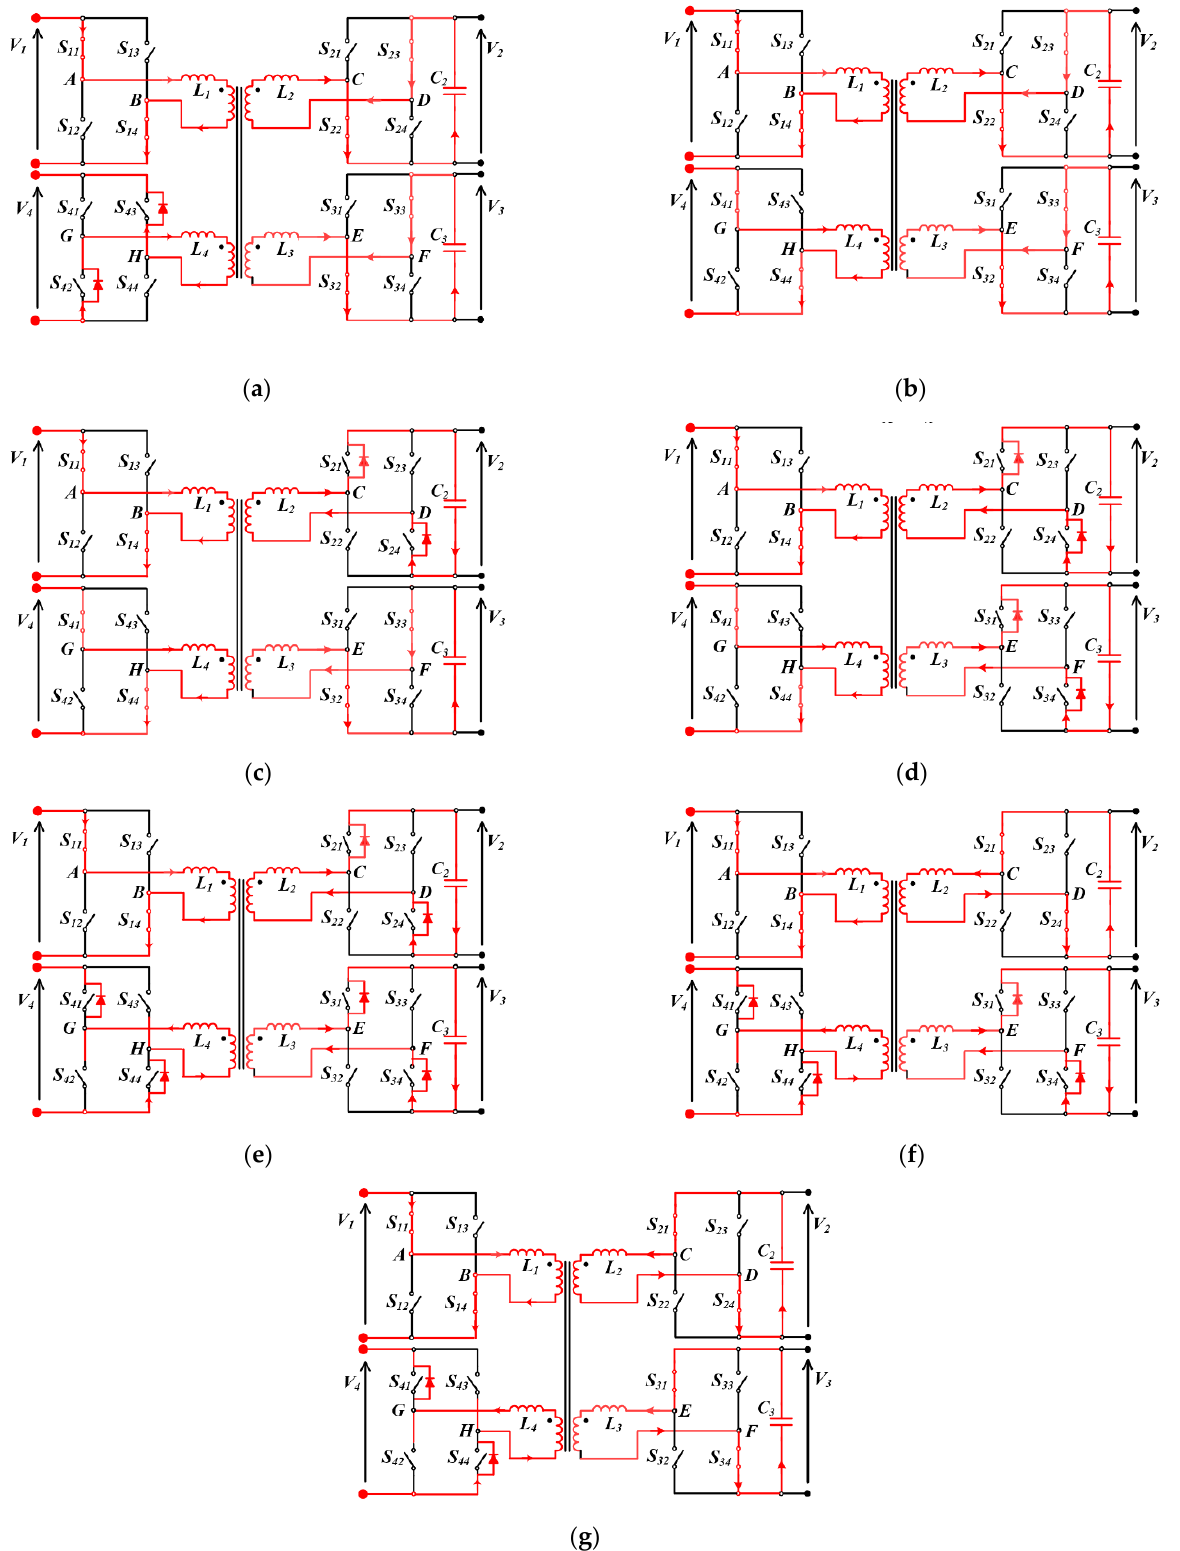
Figure 10. Equivalent circuit of the multi-port DAB converter: ( a ) time-interval 1 [0 < t < ϑ 14 ], ( b ) time-interval 2 [ ϑ 14 < t < ϑ 12 ], ( c ) time-interval 3 [ ϑ 12 < t < ϑ 13 ], ( d ) time-interval 4 [ ϑ 13 < t < ϑ t1 ], ( e ) time-interval 5 [ ϑ t1 < t < ϑ t2 ], ( f ) time-interval 6 [ ϑ t2 < t < ϑ t3 ], ( g ) time-interval 7 [ ϑ 13 < t < π].